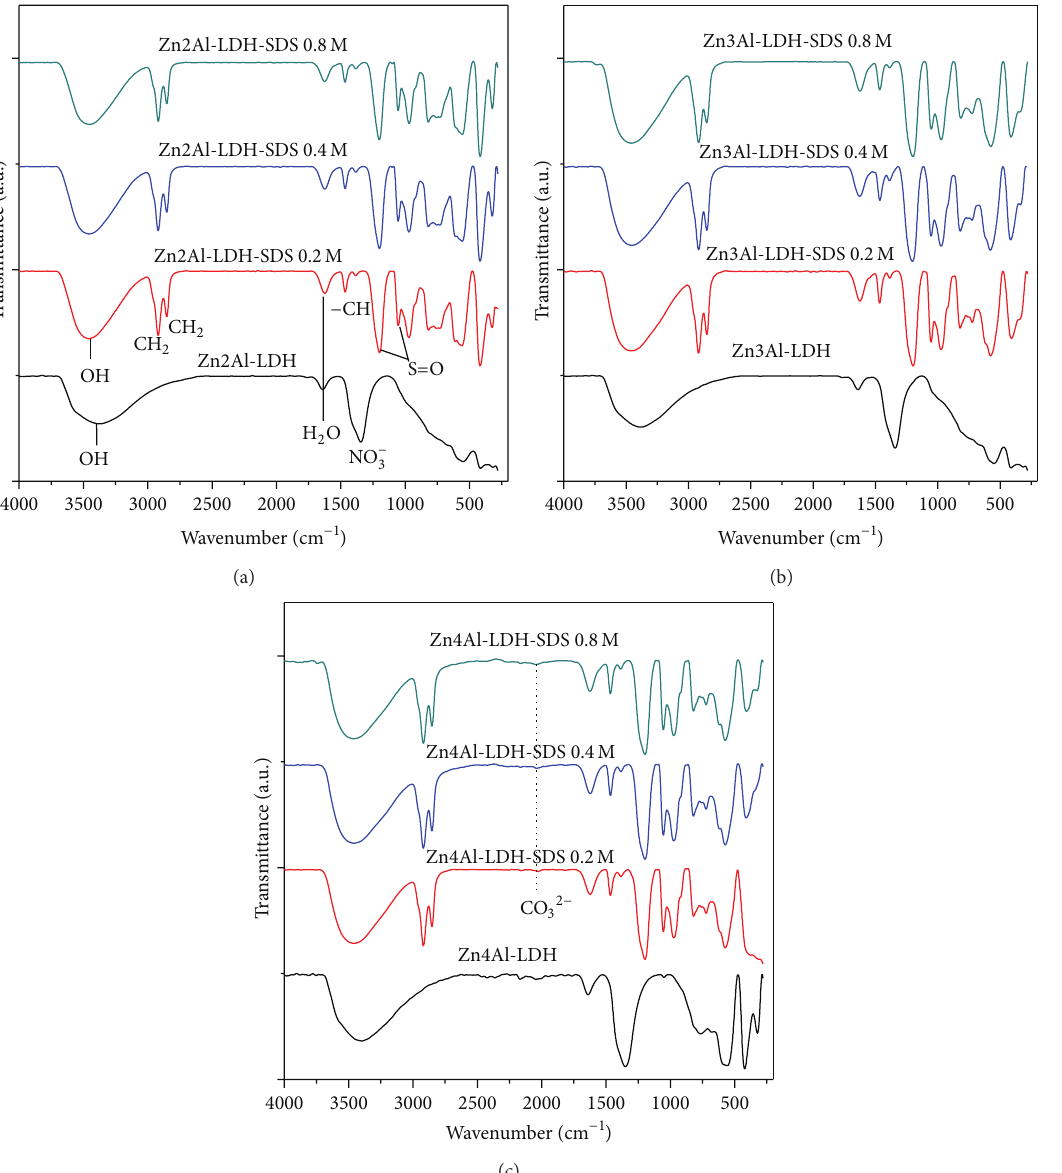
Figure 3: FT-IR spectra of Zn 𝑟 Al-LDH and LDH-SDS with different concentrations of SDS at (a) 𝑟 = 2 , (b) 𝑟 = 3 , and (c) 𝑟 = 4 .